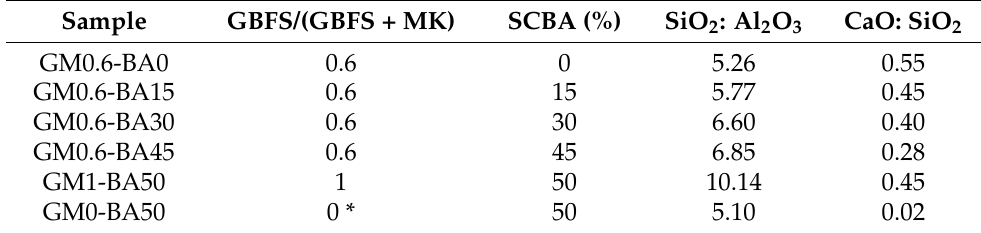
Figure 13. SEM images of the precursors: ( a ) MK, ( b ) BFS and ( c ) SCBA. Table 3. Mix proportion and oxide ratio of the